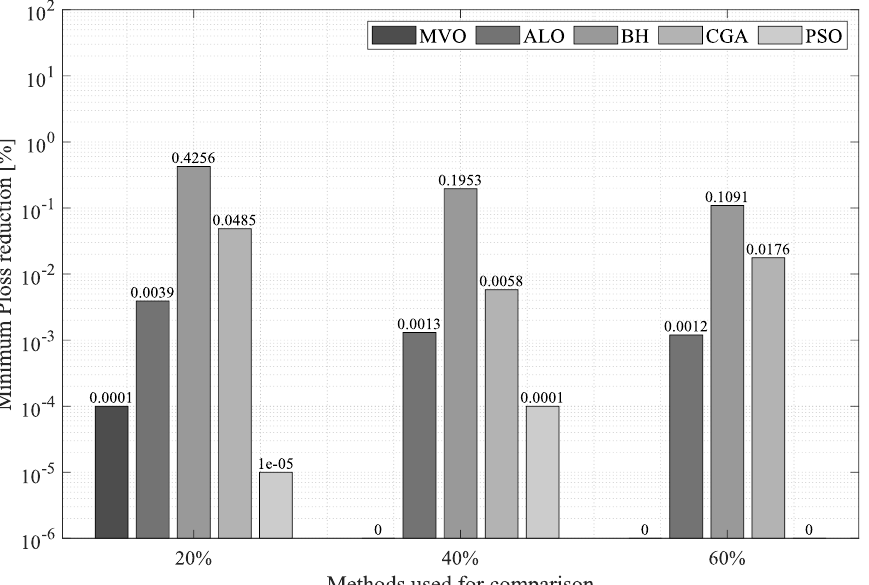
Figure 3. Percentage of reduction in minimum power losses obtained by the SSA in the 21-node system compared to that of the other methodologies.